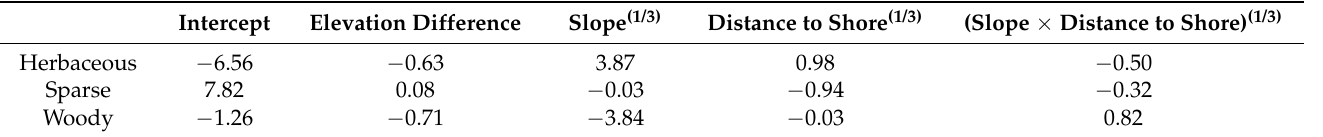
Table 4. Log-linear equation intercepts and regression coefficients developed to predict probability of 2012 herbaceous, sparse, and woody habitat types from 2012 and 2000 DEM-derived metrics.